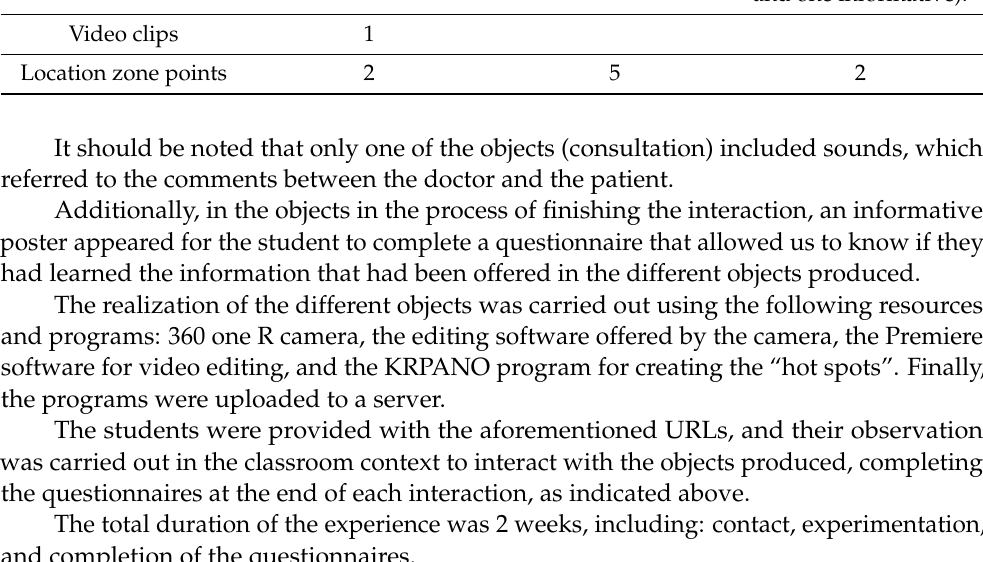
Table 2. Resources embedded in the three objects produced. Operating Room Handwashing Query 2 (one of evolution 14 (typology of and with five Informational 5 (information presentation and informative posters Hot Spots expansion typology). description). calling for attention and one informative). Video clips 1 Location zone points 2 5